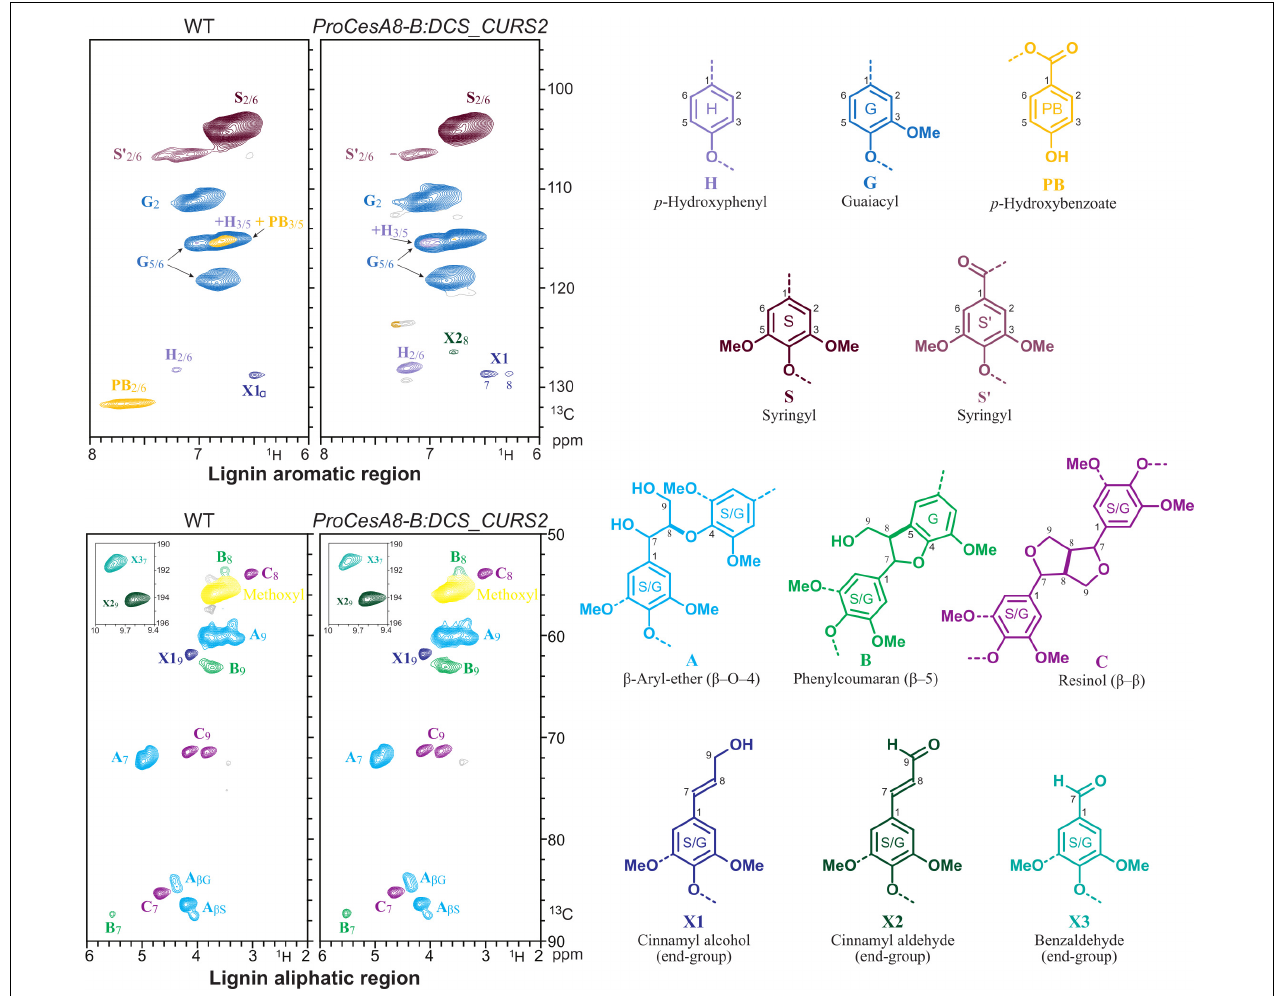
FIGURE 4 | Structural characterization of lignin via NMR. HSQC spectra of the aromatic and oxygenated aliphatic regions of whole cell walls from stems of WT and ProCesA8-B:DCS_CURS2 poplars. Integrated values for each monomeric unit H, G, S and p -hydroxybenzoate and the α -C/H correlation peaks from the major lignin interunit structures A–C are provided in Table 2 . The colors of the substructures shown match those of the corresponding signals in the HSQC spectra (where they are resolved). Representative figure for WT, n = 8 biologically independent replicates and ProCesA8-B:DCS_CURS2 , n = 28 biologically independent